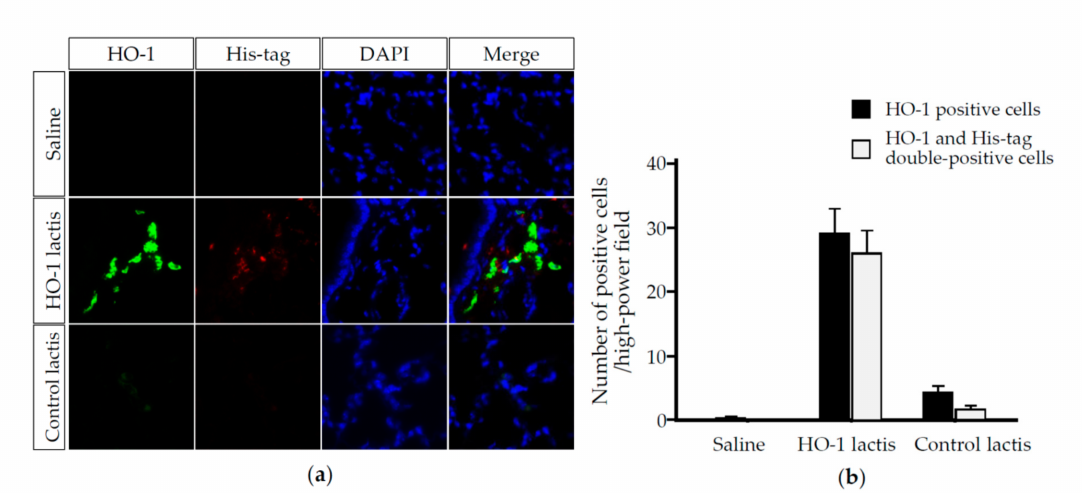
Figure 4. Analysis of HO-1 lactis-induced protein expression in the lungs. HO-1 lactis-induced protein expression was assessed by immunofluorescent staining of the lungs 48 h after nasal administration of 10 × 10 8 lactis cells or saline vehicle. ( a ) The lung specimens were incubated with anti-His tag or anti-HO-1 Abs followed by incubation with Alexa Fluor 488 (green) and DyLight 549 (red) secondary Ab. Nuclei were stained with 4,6-diamidino-2-phenylindole (DAPI: blue). Representative immunofluorescent staining images from 3 mice are shown (magnification x40). ( b ) The number of cells expressing HO-1 and His-tag was determined per high-power microscope field (BZ-X800: KEYENCE). The cell number was calculated from 10 random fields in each mouse involving 30 fields in each group. Results represent the mean ±